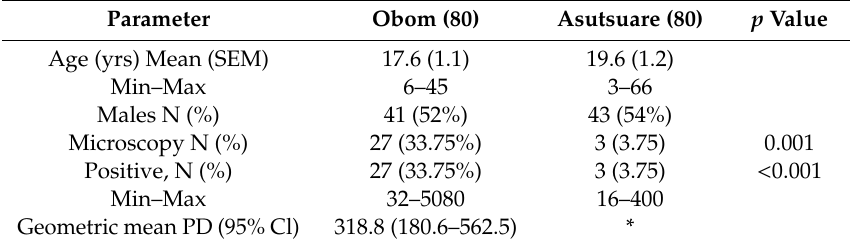
Table 1. Demographic features of study participants.